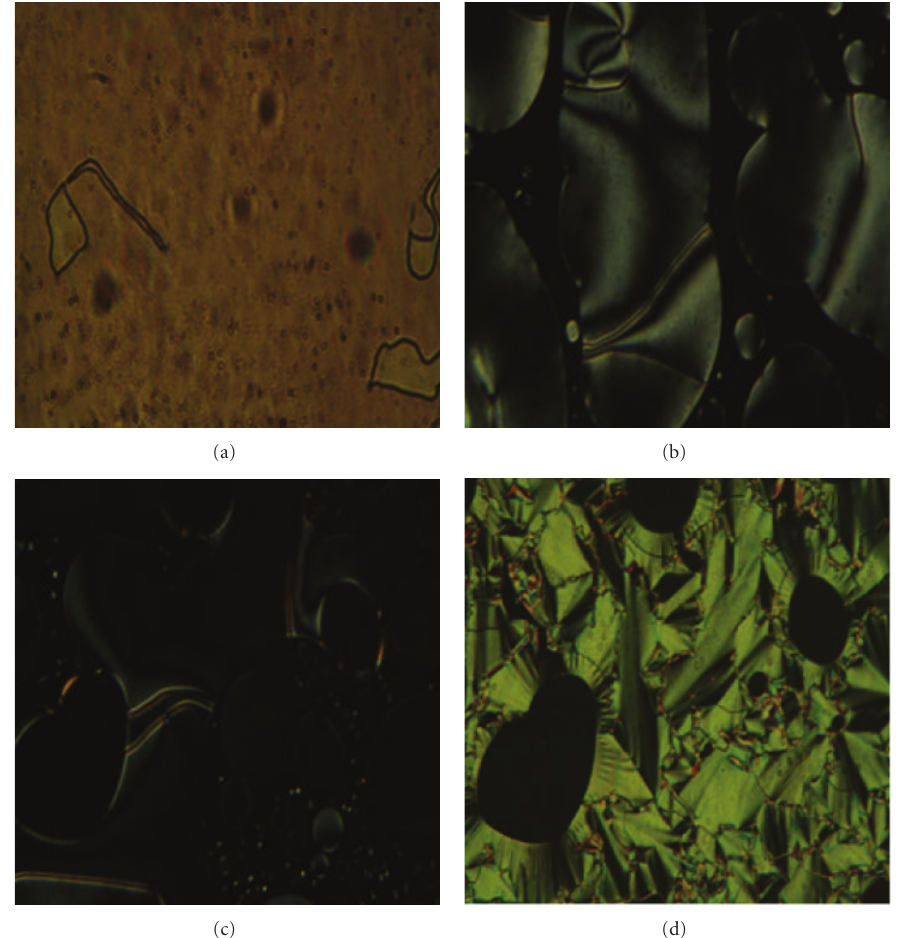
Figure 4: (a) Nematic texture of 8OBA at temperature 146.5 ◦ C, (b) nematic texture 10OBA at temperature 123.4 ◦ C, (c) nematic texture of 12OBA at temperature 135 ◦ C and (d) smectic texture of 12OBA at temperature 100 ◦